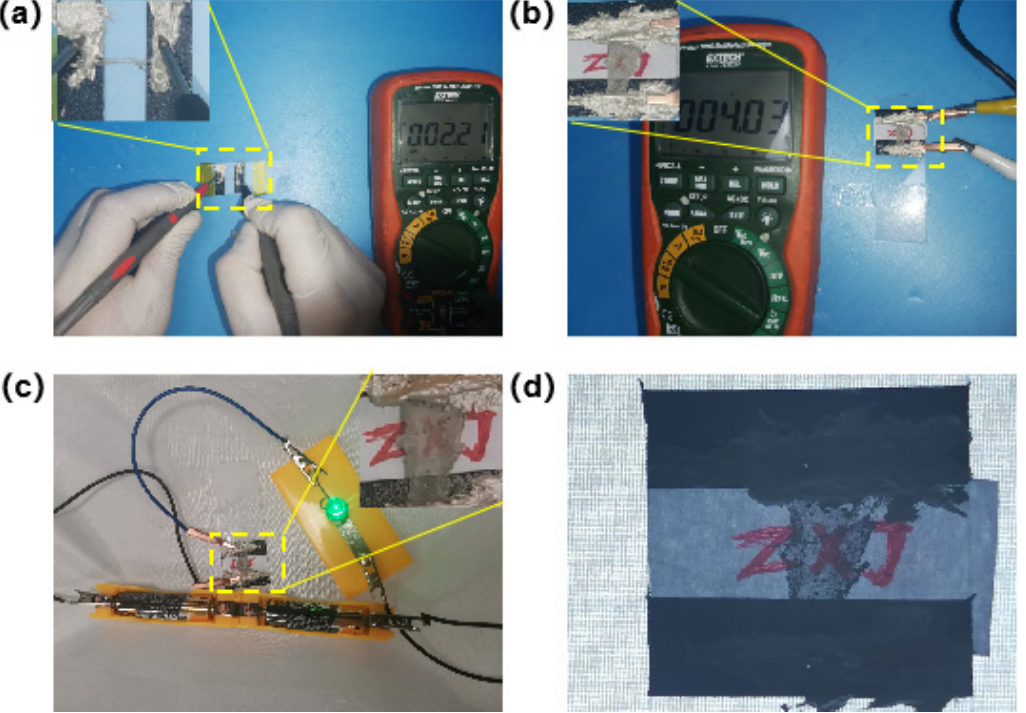
Figure 6. The resistance of a silver fiber bundle ( a ) and a silver-fiber network ( b ). ( c ) The highly conductive silver-fiber network illuminates a bulb at 3 V. ( d ) Demonstrated transparency of the highly conductive silver-fiber network.